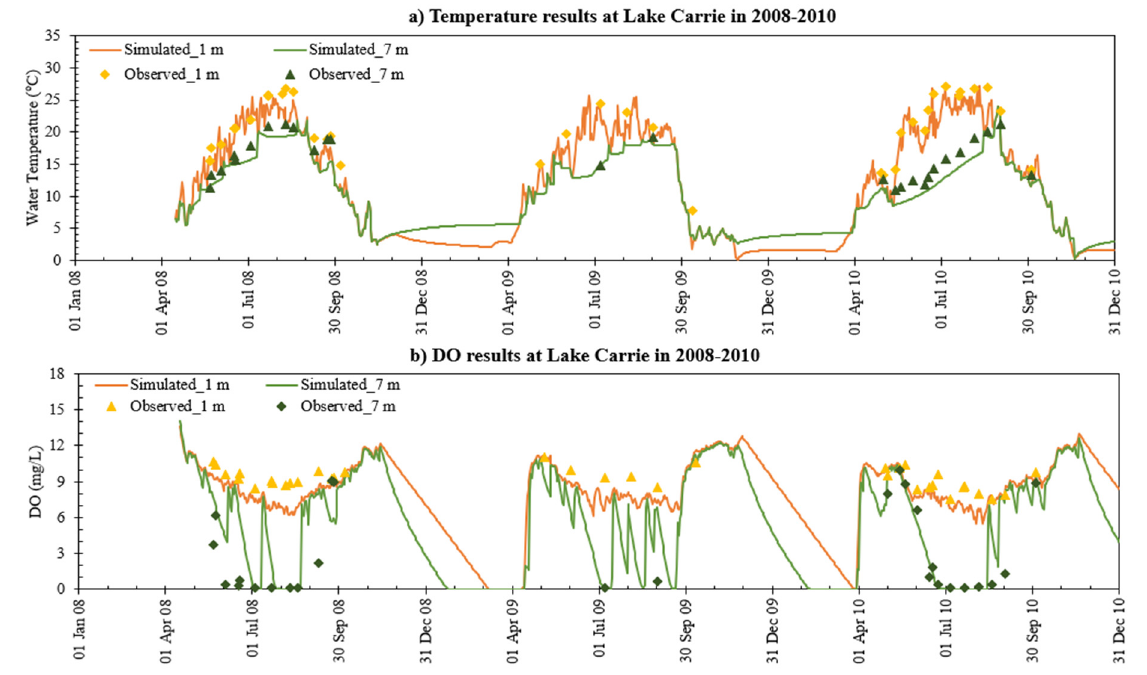
Figure 8. Time series of simulated ( a ) water temperature and ( b ) DO at two depths in Lake Carrie in 2008–2010. Table 3. Statistical parameters for six lakes when simulated profiles were compared with